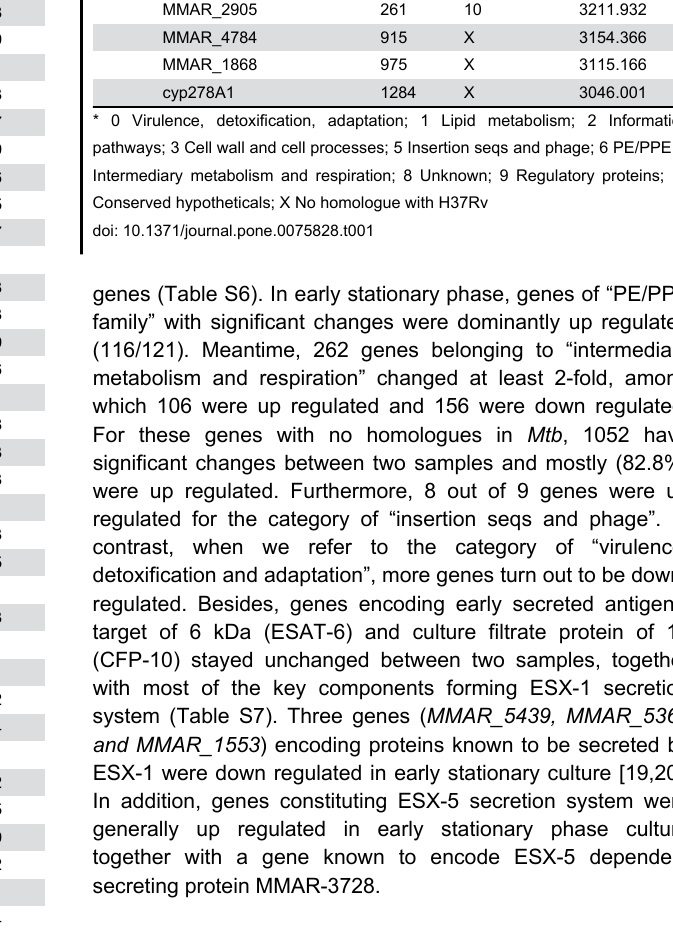
next to each other are transcribed together, so we predicted operons on a genome-wide scale. We considered gene expression level in our sequence profile, coverage of intergenic regions (IGRs) and gene orientation as basic principles for operon prediction (See Materials and Methods). As a result, 898 operons were predicted in total throughout M. marinum genome from log phase culture and 978 from early stationary phase culture. In addition, there were 360 predicted operons in common between these two samples (Table S8). In both samples, most predicted operons were small transcriptional units containing only 2 or 3 genes. For example, in log phase culture, 860 operons have two or three genes, accounting for 96% of the total operons predicted (76% and 20%